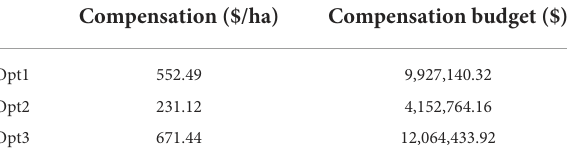
TABLE 3 Budgets needed to compensate for water